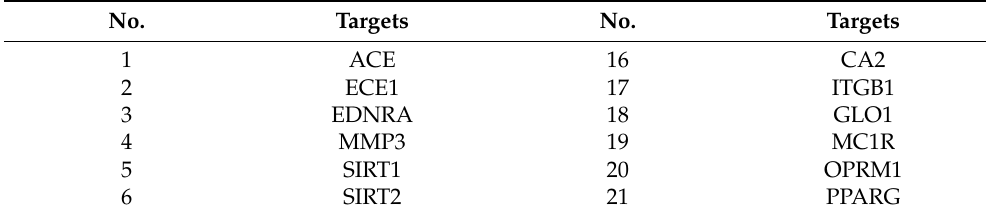
Figure 2. ( A ) The number of 242 overlapping targeted targets from SEA (375 targets) and STP (355 targets) on AMPs’ targets. ( B ) The number of 30 overlapping targets between the number of 242 overlapping targets and 959 bacterial respond targets. Table 1. The number of 30 targets overlapped between 959 AMPs’ targets and the overlapping 242 targets.